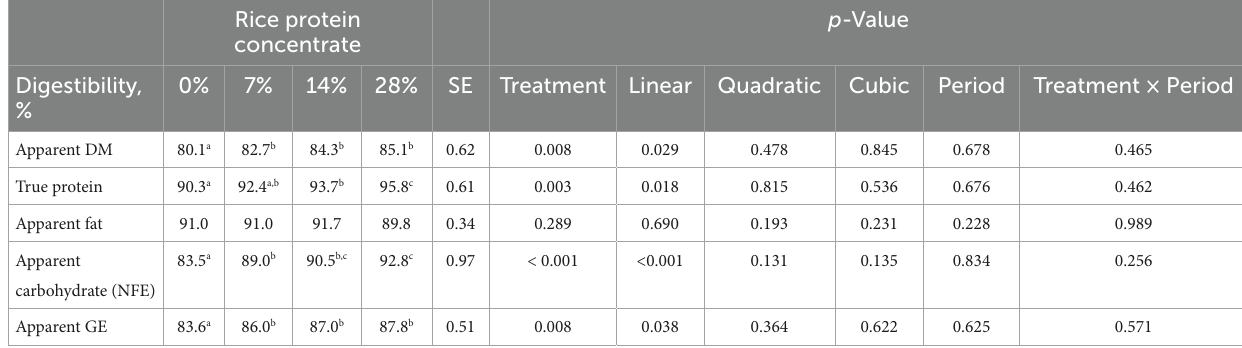
TABLE 5 Total tract apparent and true macronutrient digestibility in cats consuming increasing levels of rice protein